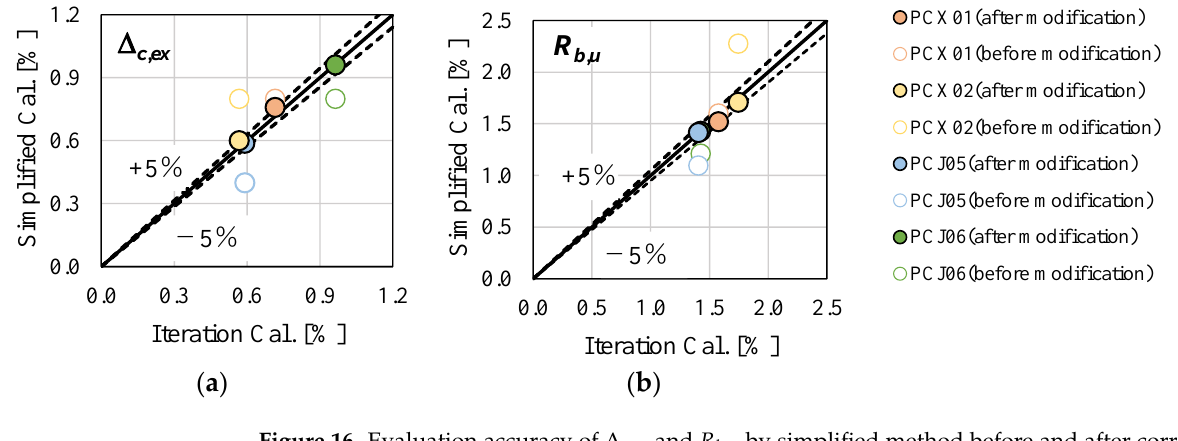
Figure 16. Evaluation accuracy of Δ c,ex and R b , u by simplified method before and after correction: ( a ) D c , ex ; ( b ) R b , u .